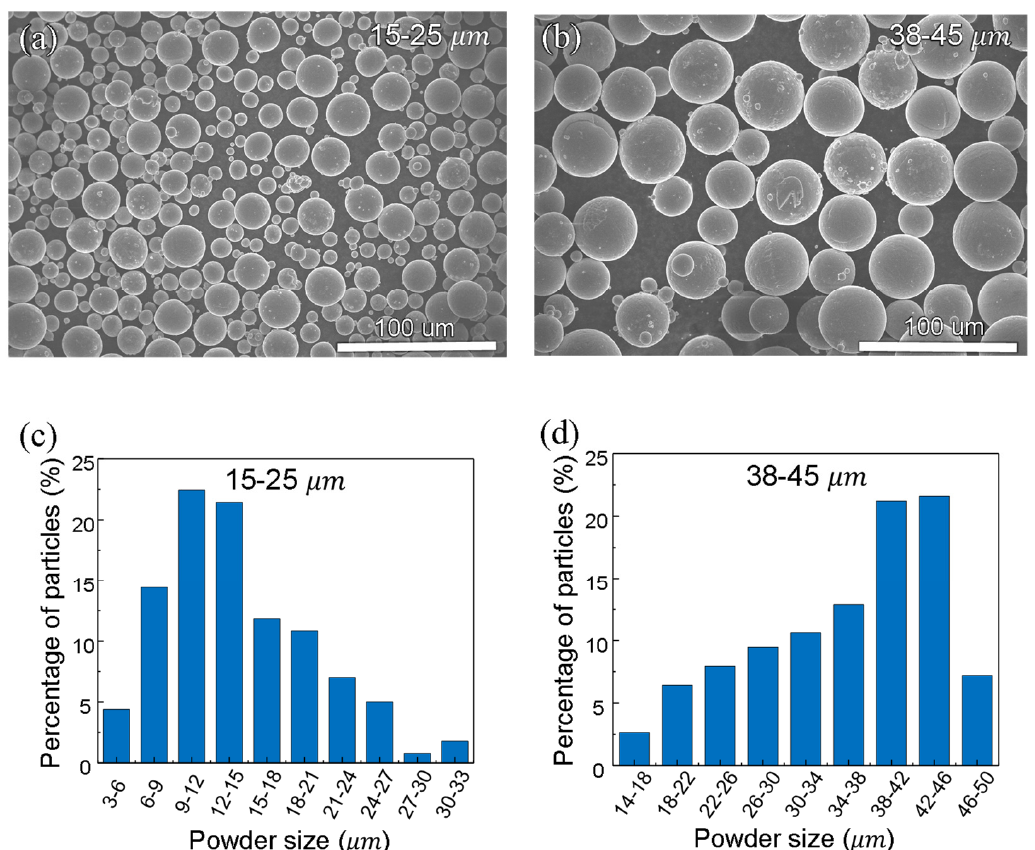
Figure 1. Morphology and size distribution of the feedstock powders. ( a , b ) SEM images of Pyrogen- esis 15–25 um powders ( a ) and Pyrogenesis 38–45 um powders ( b ). ( c , d ) Particle size distribution of Pyrogenesis 15–25 um powders ( c ) and Pyrogenesis 38–45 um powders ( d ). The percentage is num- ber percentage.